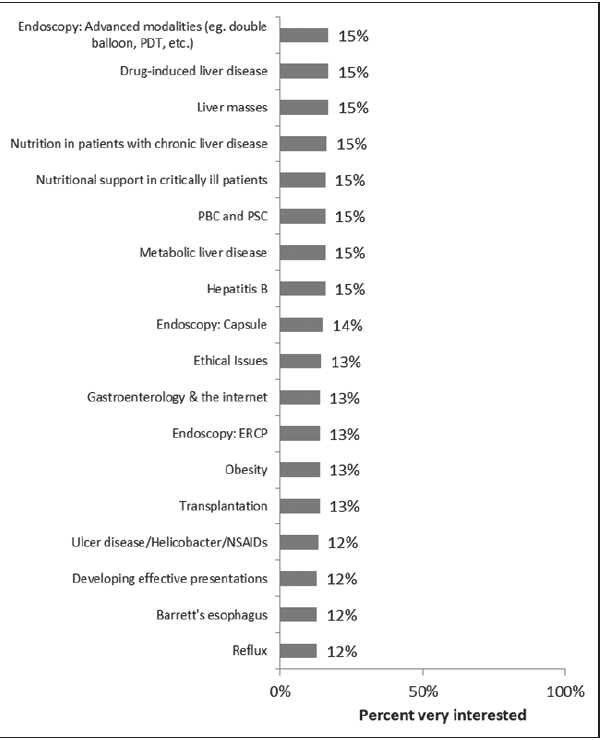
Figure 3) Educational topics in which 12% to 15% of respondents were ‘very interested’. ERCP Endoscopic retrograde cholangiopan-